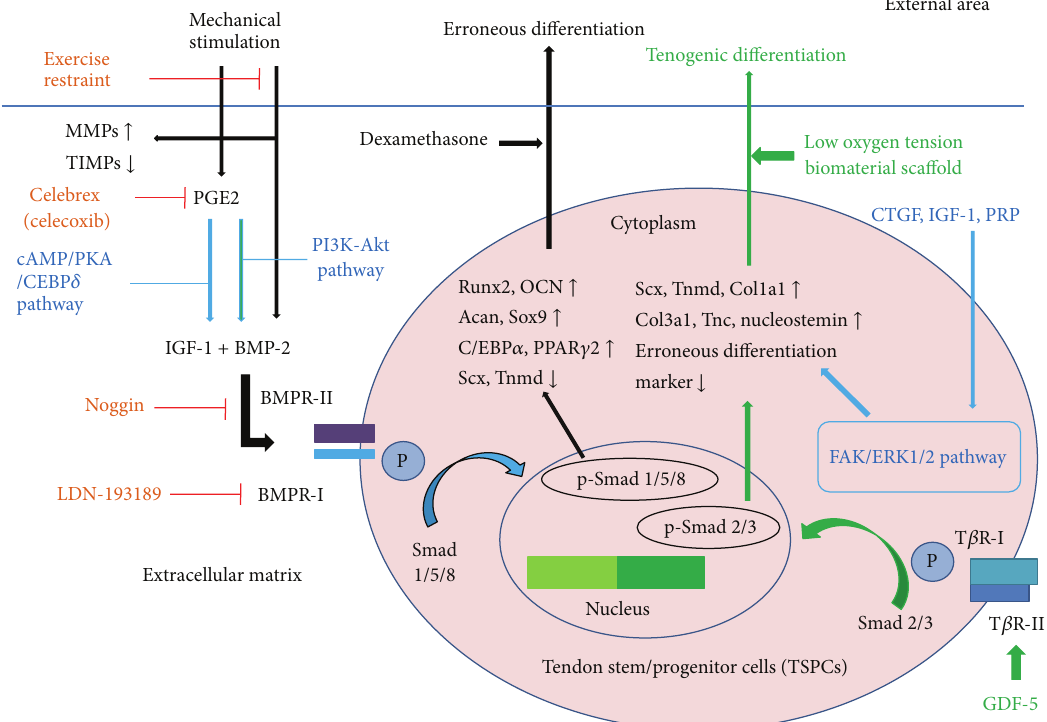
Figure 2: Potential regulations of endogenous